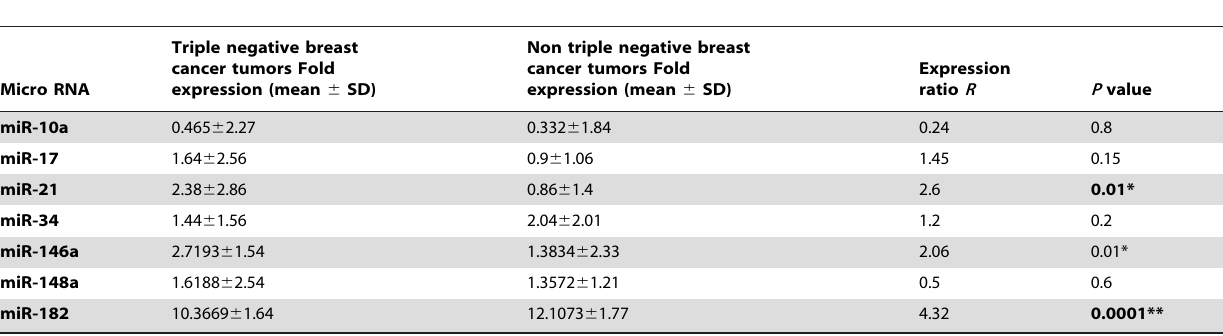
Table 5. Comparison of the mean fold expression levels (Log 2 transformed) of the different studied microRNAs between both triple negative and non triple negative breast